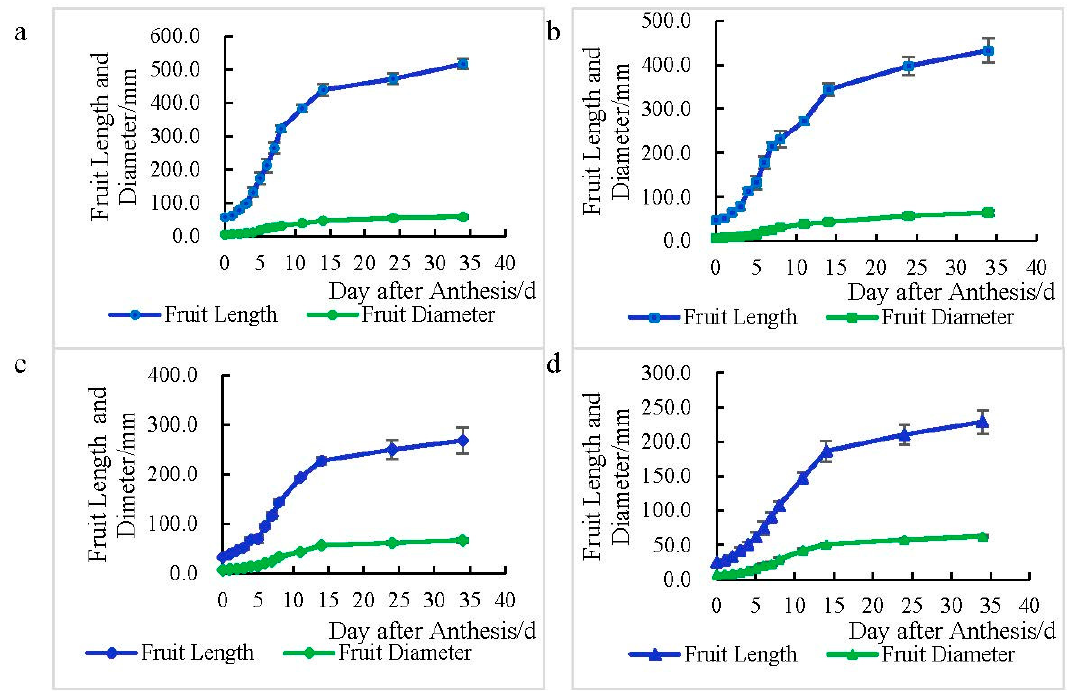
Figure 3. The dynamic growth of fruit length and fruit diameter in four types of cucumber